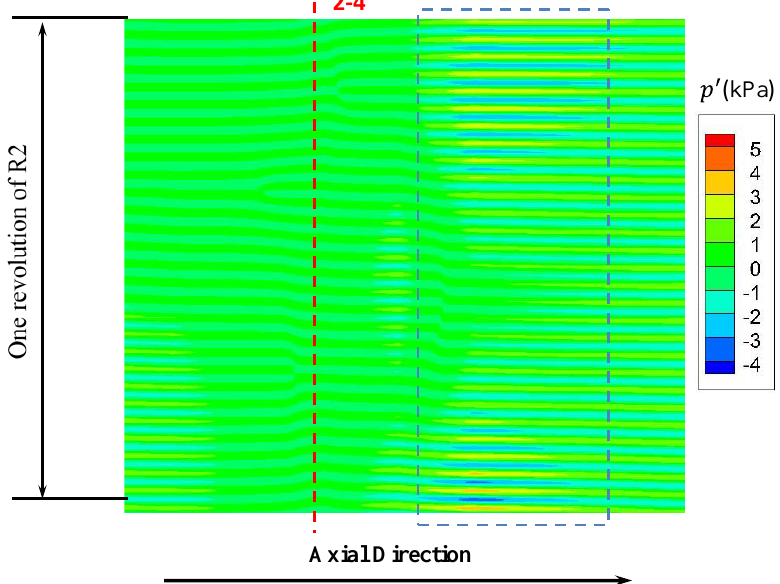
Figure 9. The propagation of the R1-2BPF disturbance within the R2 passage .